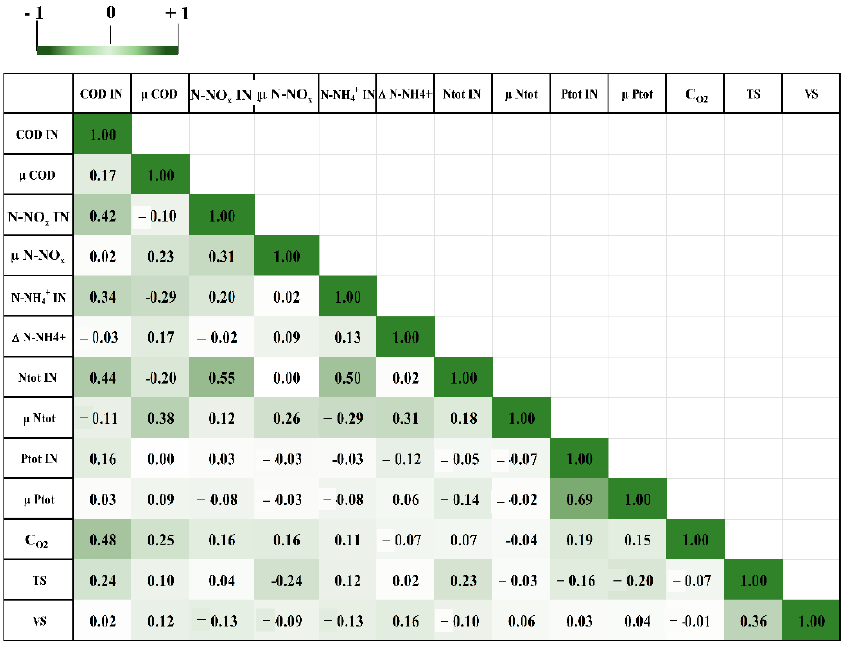
Figure 3. Spearman’s correlation matrix.